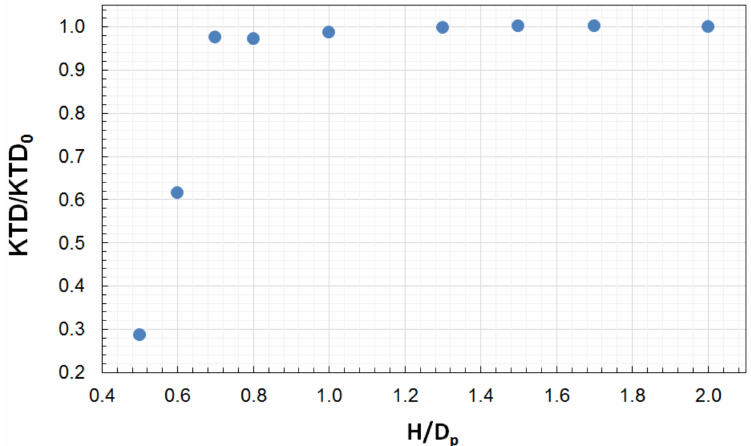
Figure 20. Variations in duct thrust, KTD, with propulsor submergence, H/Dp, at J = 0.6. (KTD 0 refers to the corresponding value in unbounded